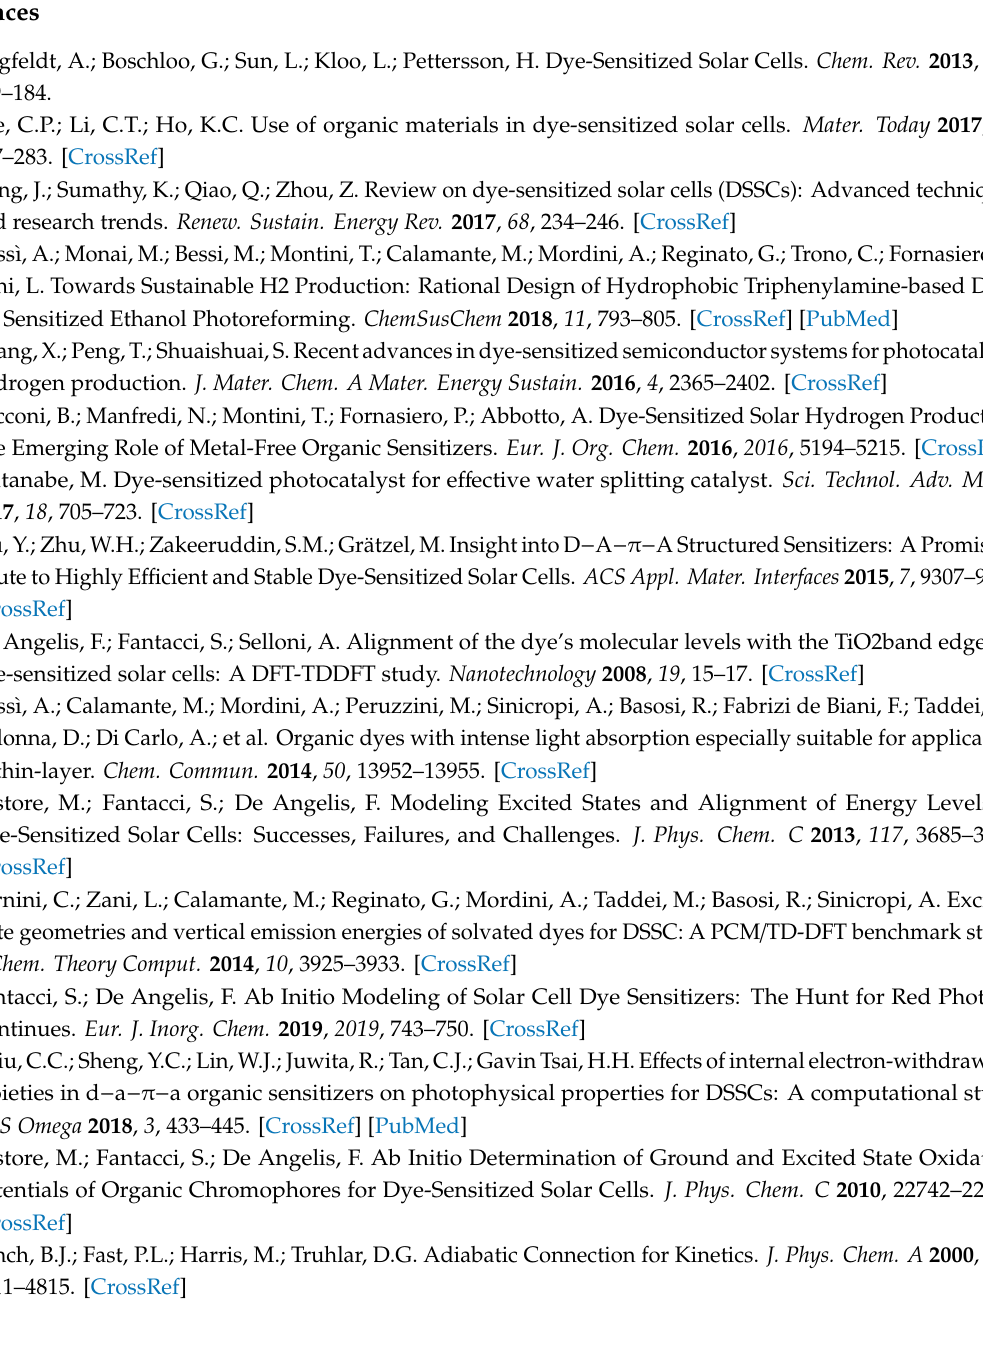
given in brackets. Table S2: DFT frontier molecular orbitals for all dyes obtained at MPW1K / 6-31 + G* level in vacuo. Table S3: Experimental ( E S +/ S ), computed GSRP (eV) and - ε (HOMO) of all investigated dyes. Cartesian Coordinated of all the investigated dyes in gas-phase and in solvent, Figure S1. MPW1K / 6-31 + G* optimized geometries of all dyes computed in vacuo and in DCM (in brackets). Dihedral angles are given in